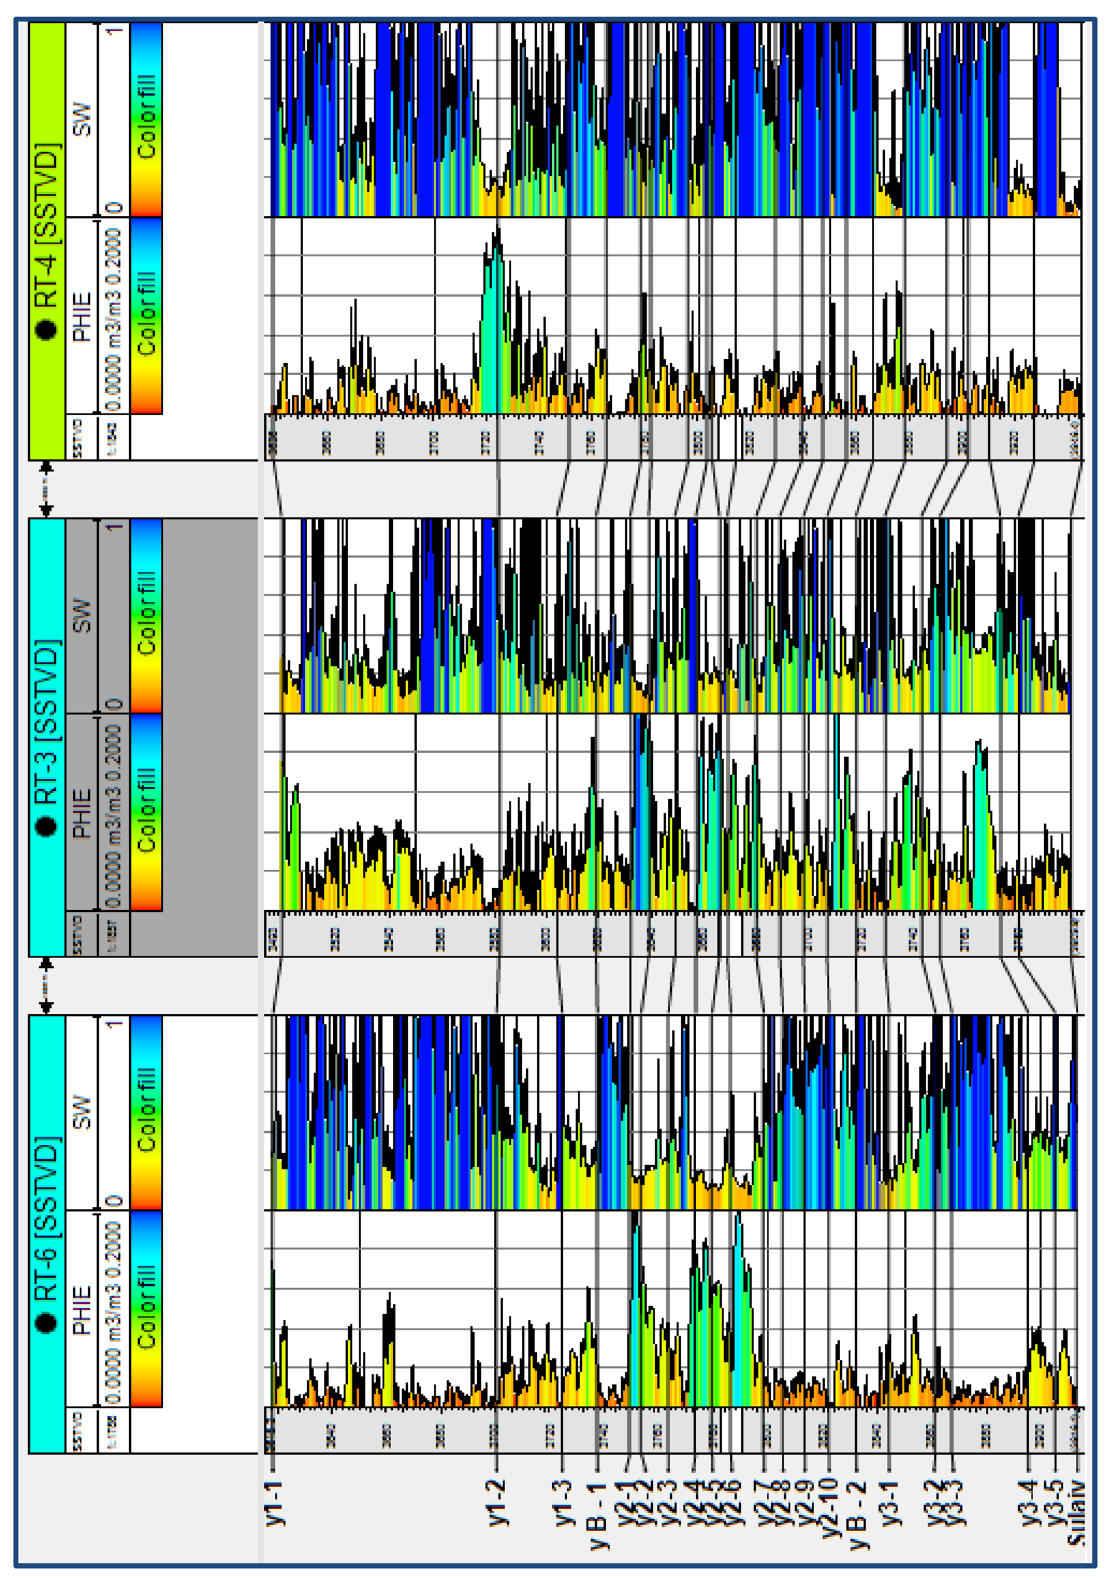
Fig. 7 Porosity and Water saturation section for wells Rt-6, 3, and 4 in Yamama